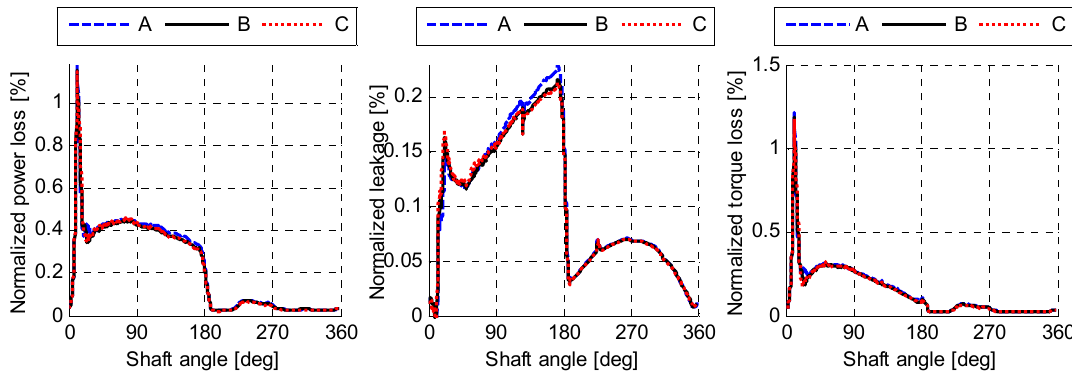
Figure 23. Normalized piston/cylinder interface performance for different size units.